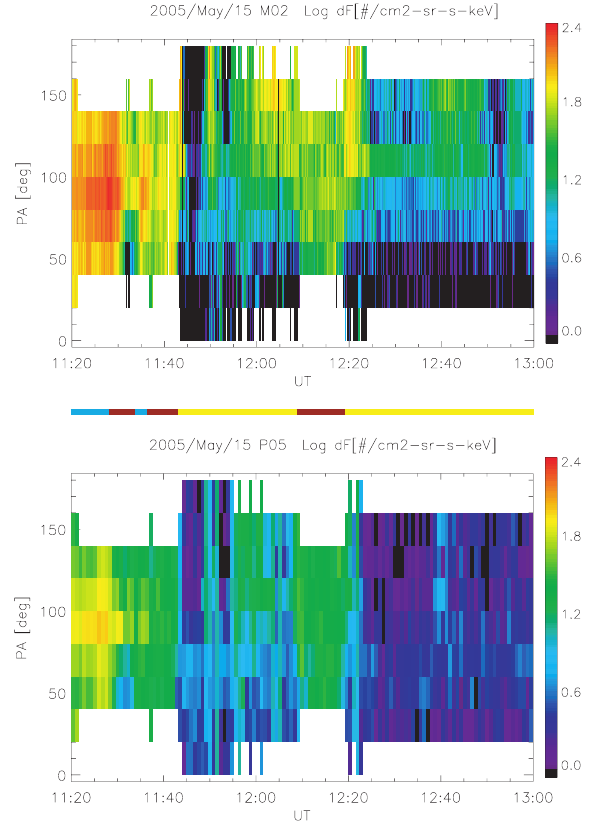
Fig. 3. Pitch angle distributions of oxygen ions (187-221 keV) in the upper panel and protons (154-228 keV) in the lower. The bar in the middle is identical to the one in Figure 2.